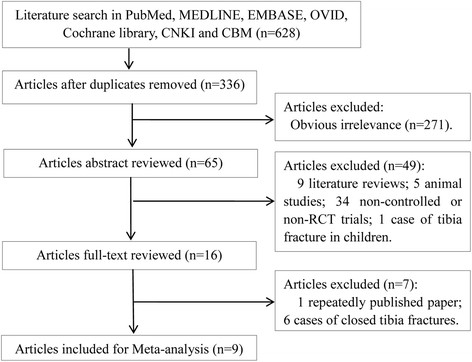
Literature search and study selection.